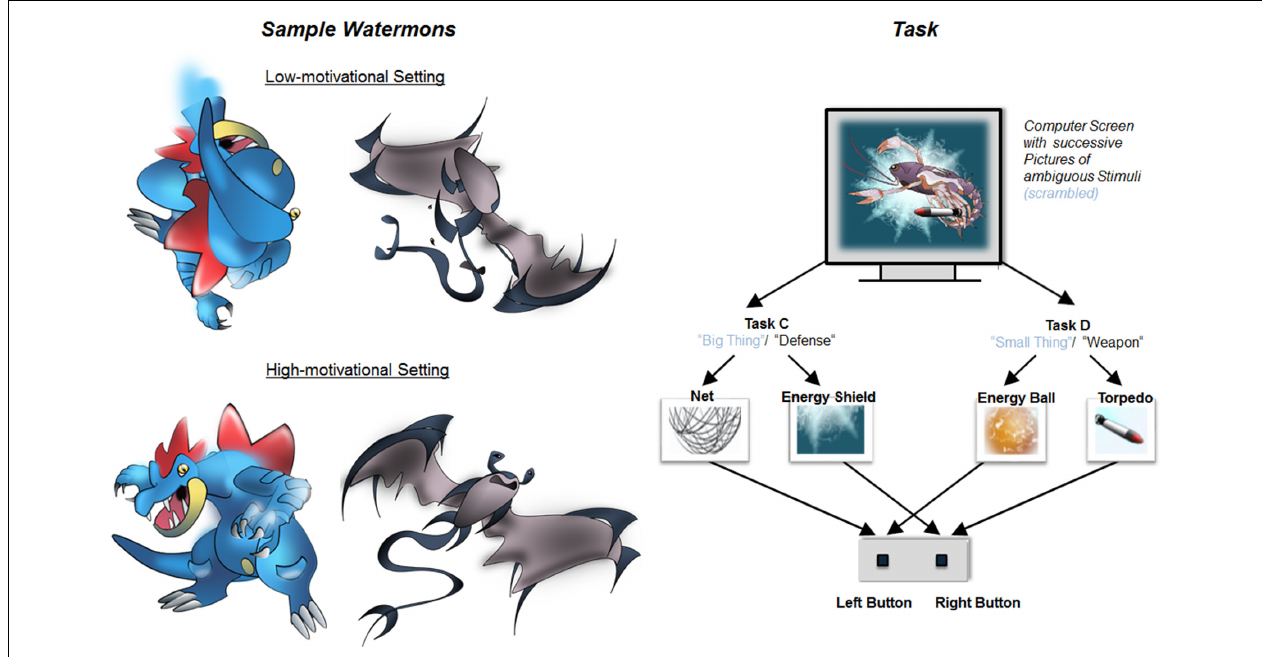
FIGURE 2 | Sample stimuli (left panel) and overview of the employed task-switching paradigm (right panel) for the low- and the high-motivational condition. Discrepancies in the low-motivational group are highlighted in blue